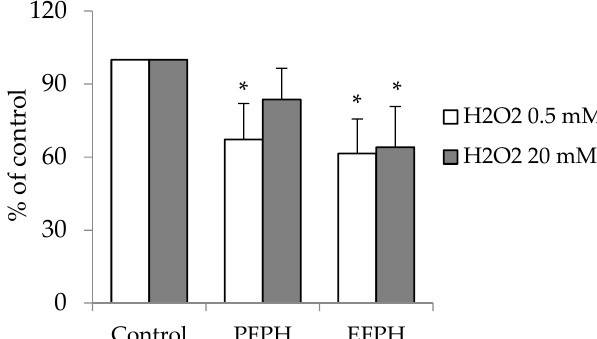
Figure 5. Relative reactive oxygen species levels in undifferentiated Caco2/TC7 cells treated (24 h) or not with fenugreek proteins hydrolysates. Data are presented as mean ± SD. The experiment was done in triplicate (each performed with six determinations). Superscripted (*) means are significantly different ( p ≤ 0.05) compared to their respective control. Control: Untreated cells. PFPH: Purafect fenugreek proteins hydrolysate. EFPH: Esperase fenugreek proteins hydrolysate. The hydrolysates were used at a final concentration of 1 mg/mL.